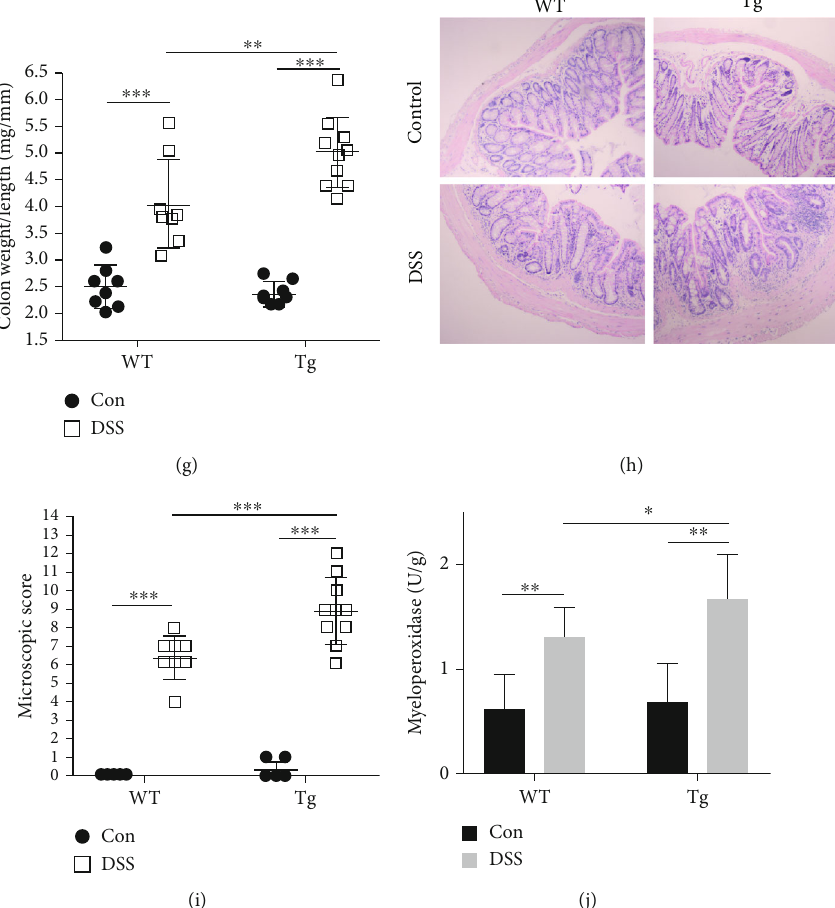
Figure 2: TL1A promotes colon in fl ammation in the DSS-induced intestinal fi brosis model. Transgenic (Tg) and wildtype (WT) mice were subjected to 2.0% dextran sulfate sodium (DSS) to generate an intestinal fi brosis model. There were four study groups: control/WT group ( n = 8 ), control/Tg group ( n = 8 ), DSS/WT group ( n = 8 ), and DSS/Tg group ( n = 10 ). (a) The percent change in body weight of mice during modeling. (b) Postmodeling disease activity index (DAI) based on body weight, stool characteristics, and fecal occult blood of mice. (c, d) Macroscopic damage and score. (e) Weight of colon. (f) Length of colon. (g) Colon weight/length ratio. (h) Representative images of H&E-stained colonic tissue sections of WT and Tg mice (100x). (i) Microscopic damage score. (j) Myeloperoxidase (MPO) activity. Data were given as mean ± standard deviation (SD). As compared to the control group: ∗ P < 0 : 05 , ∗∗ P ≤ 0 : 01 , and ∗∗∗ P ≤ 0 : 001